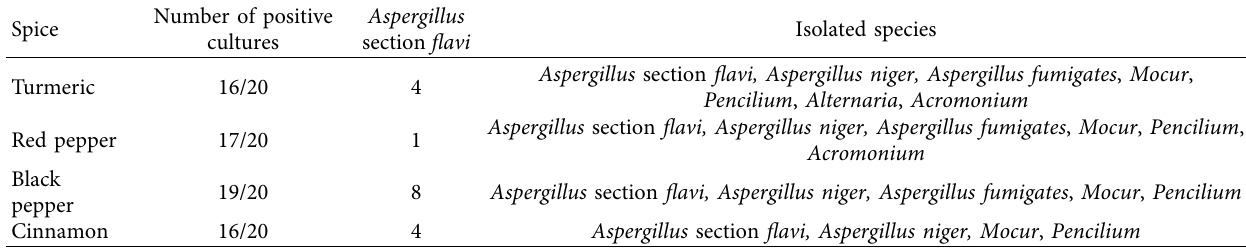
Table 4: The frequency of fungal contamination of different spices according to species of fungi and number of culture positive samples. Number of positive Spice cultures